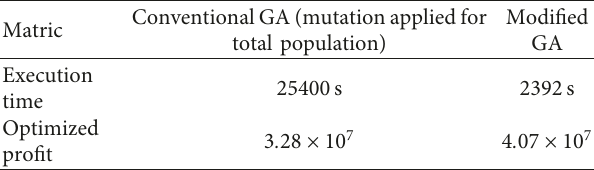
Table 5: Comparisons of optimization